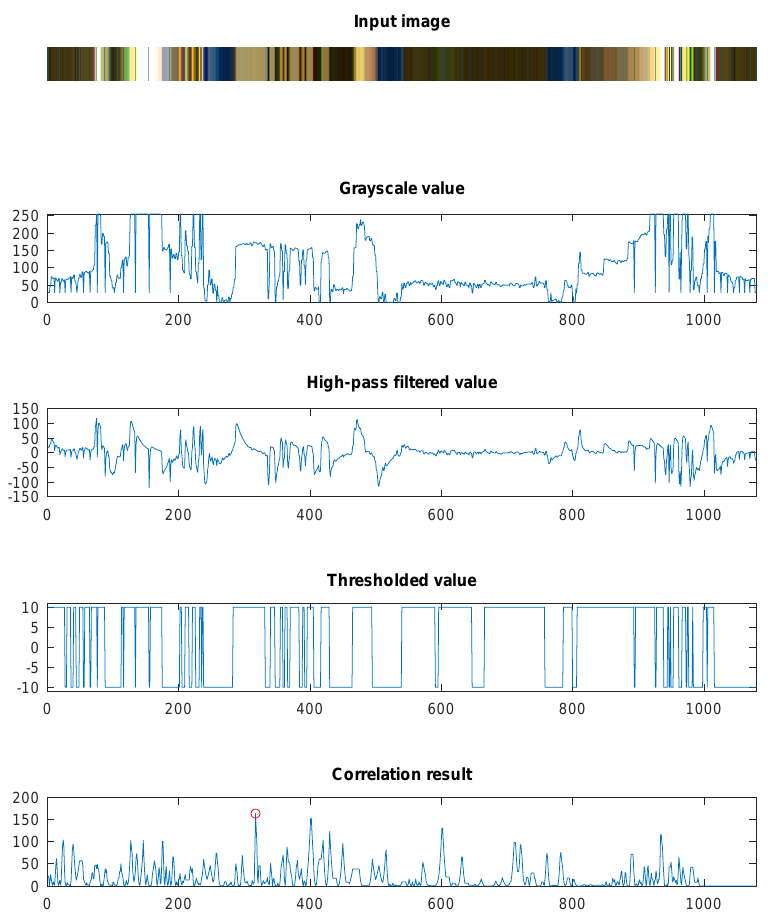
Figure 7. Results of line data analysis and